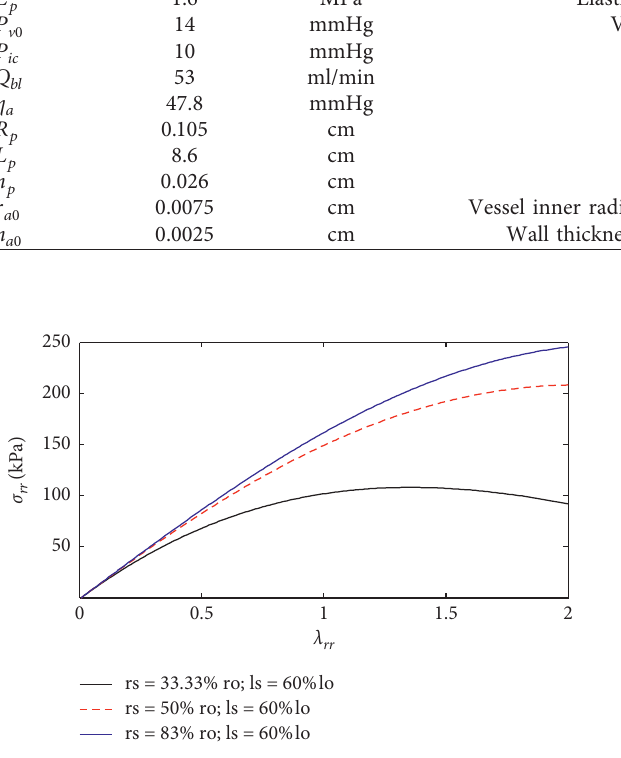
Figure 5: Study of the influence of stenosis on axial stress.